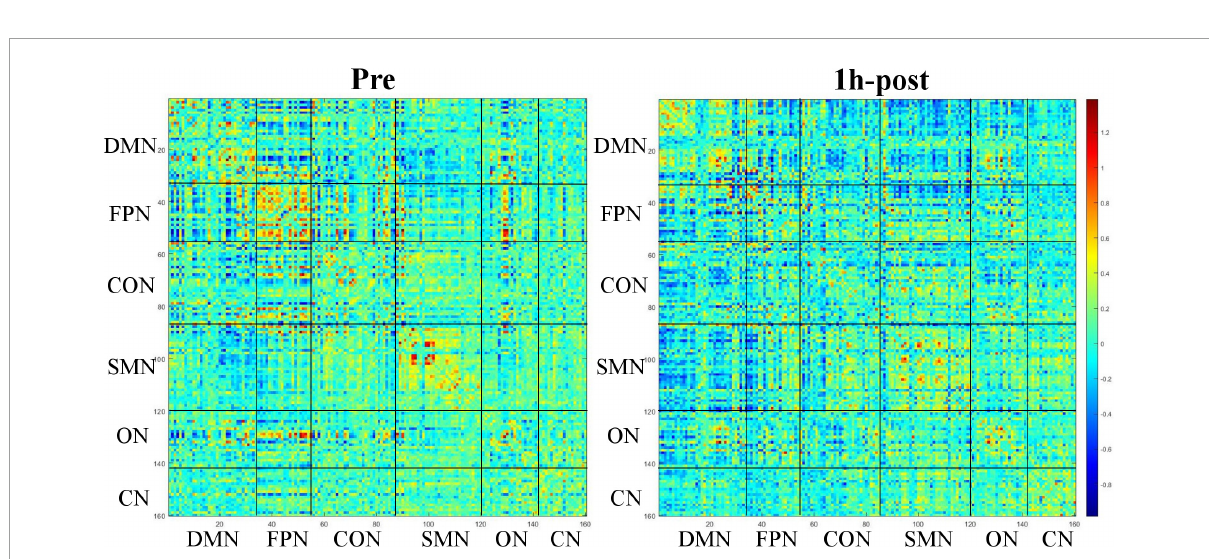
FIGURE2 Functional connectivity matrix obtained from a 31-year-old male participant before and 1 h after drinking. The color of the blocks in the matrix represents the connection strength of the nodes where the horizontal and vertical axes